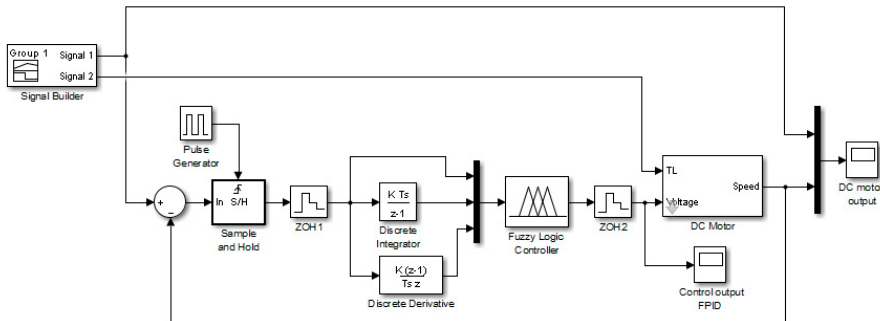
Figure 18. The proposed FLC-controlled system in discrete form.